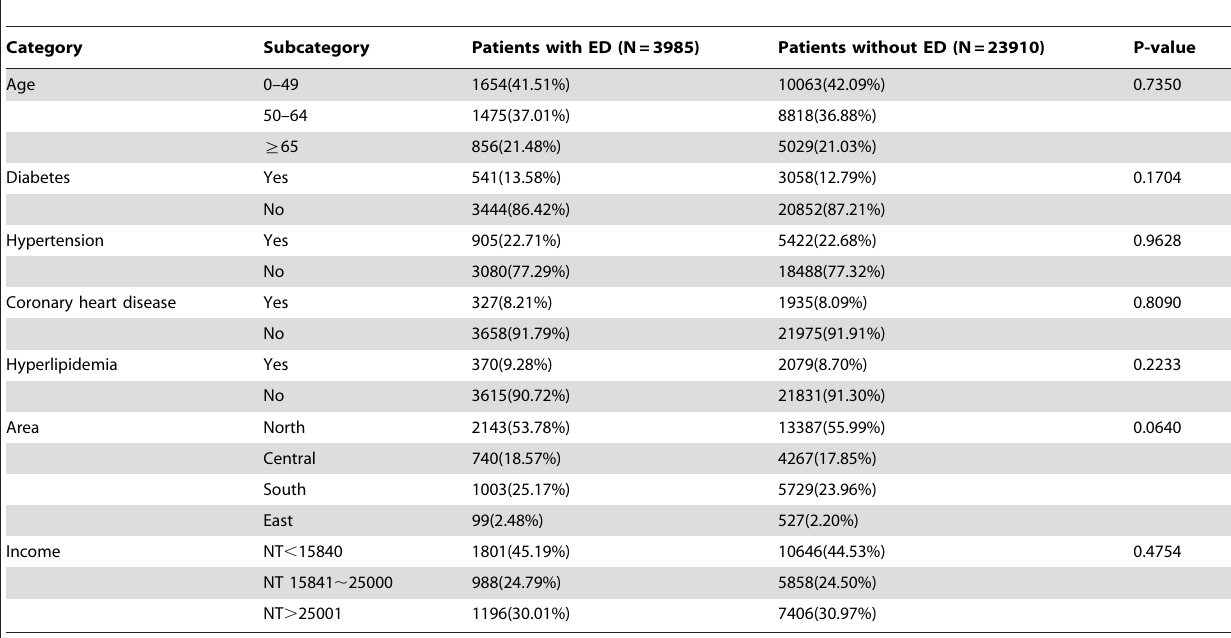
Table 1. Demographic characteristics and comorbid medical disorders for patients with and without erectile dysfunction (ED) in